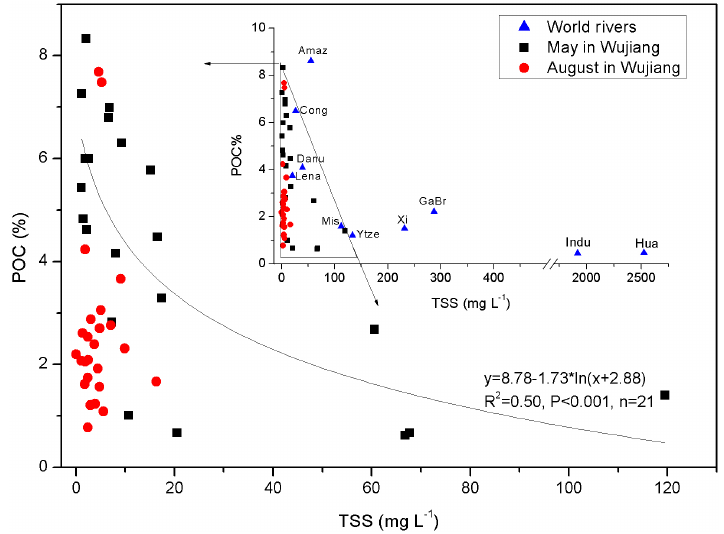
Figure 6. Correlations between TSS concentrations (mgL − 1 ) and POC (%). The related data were summarized in Table 2. Amazon, Changjiang, Congo, Danube, Ganges–Brahmaputra, Huanghe, Indus, Lena, Mackenzie, Mississippi, St. Lawrence, Wujiang, Xijiang, Yenisey, and Zhujiang are abbreviated to Amaz, Chang, Cong, Danu, Gabr, Hua, Inds, Lena, Mack, Mis, StL, Wu, Xi, Yens, and Zhu,